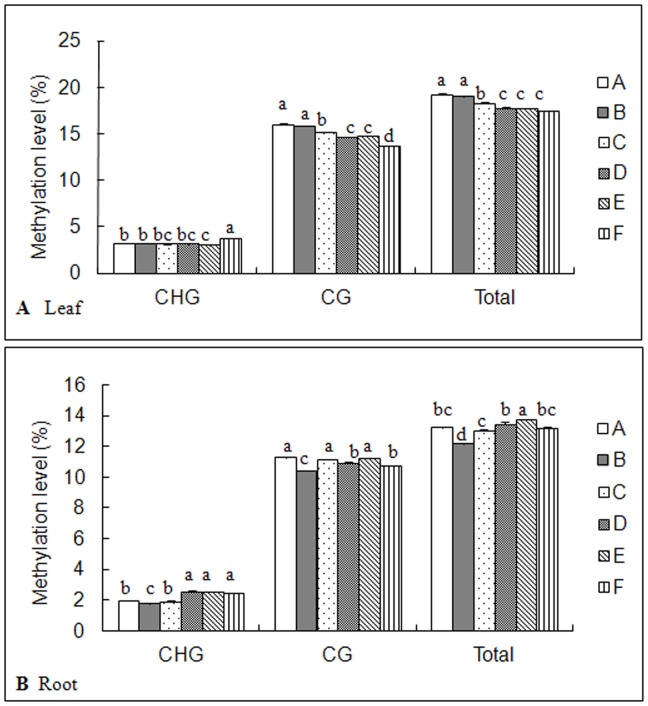
Effects of different salt stresses on cytosine methylation level in C.virgata.A: control, B: NaCl, C: Na2SO4, D: NaHCO3, E: Na2CO3, F: Mix. Data represent means ±S.E. of four replicates. Different lower-case letters represent significant difference among treatments at the 5% level, according to least significant difference (LSD) test.